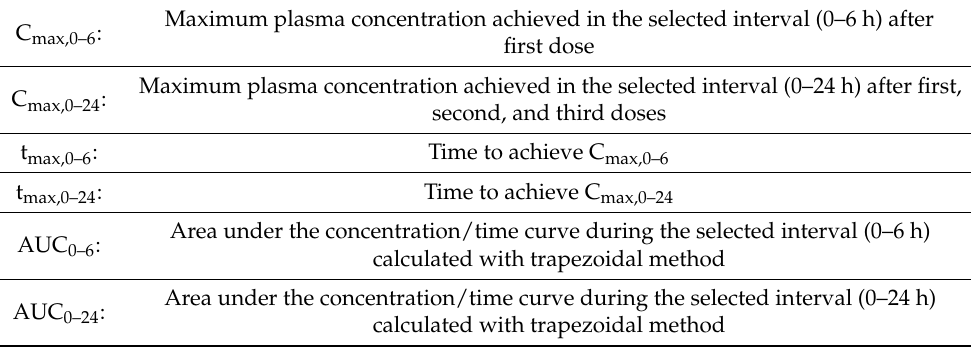
Table 1. Pharmacokinetic parameters planned to be measured and/or calculated for plasma rifamycin SV after single